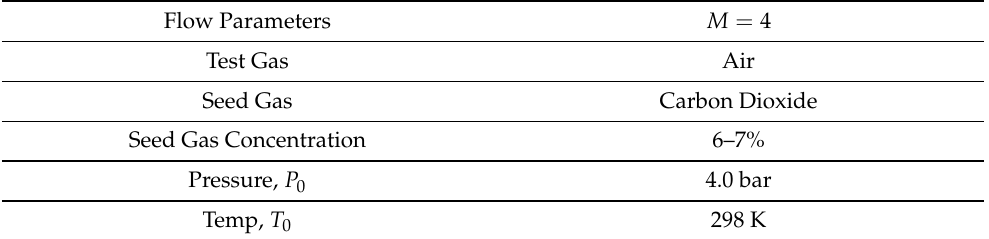
Table 1. Summary of flow parameters for Mie Scattering experimental tests.